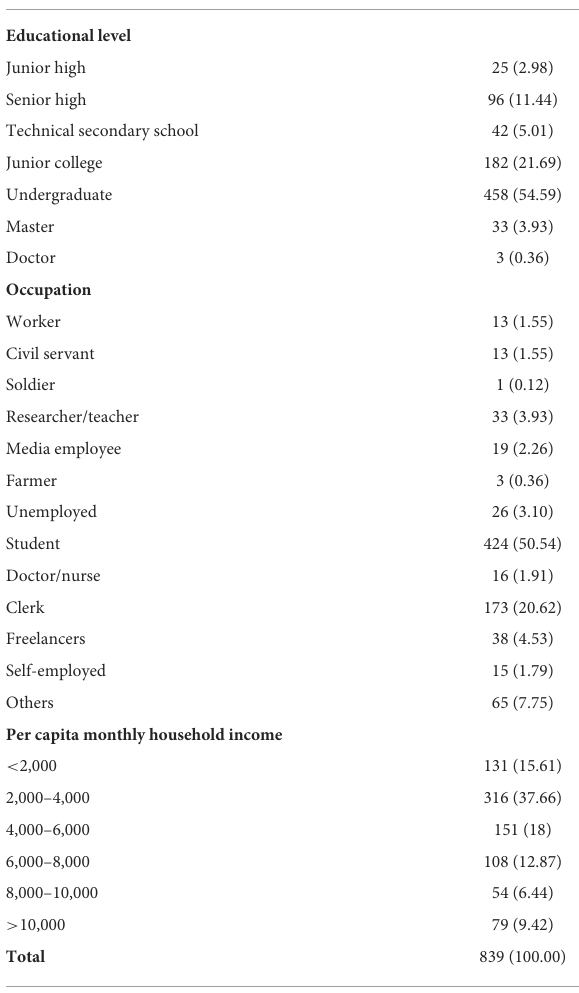
TABLE 1 Demographic characteristics of